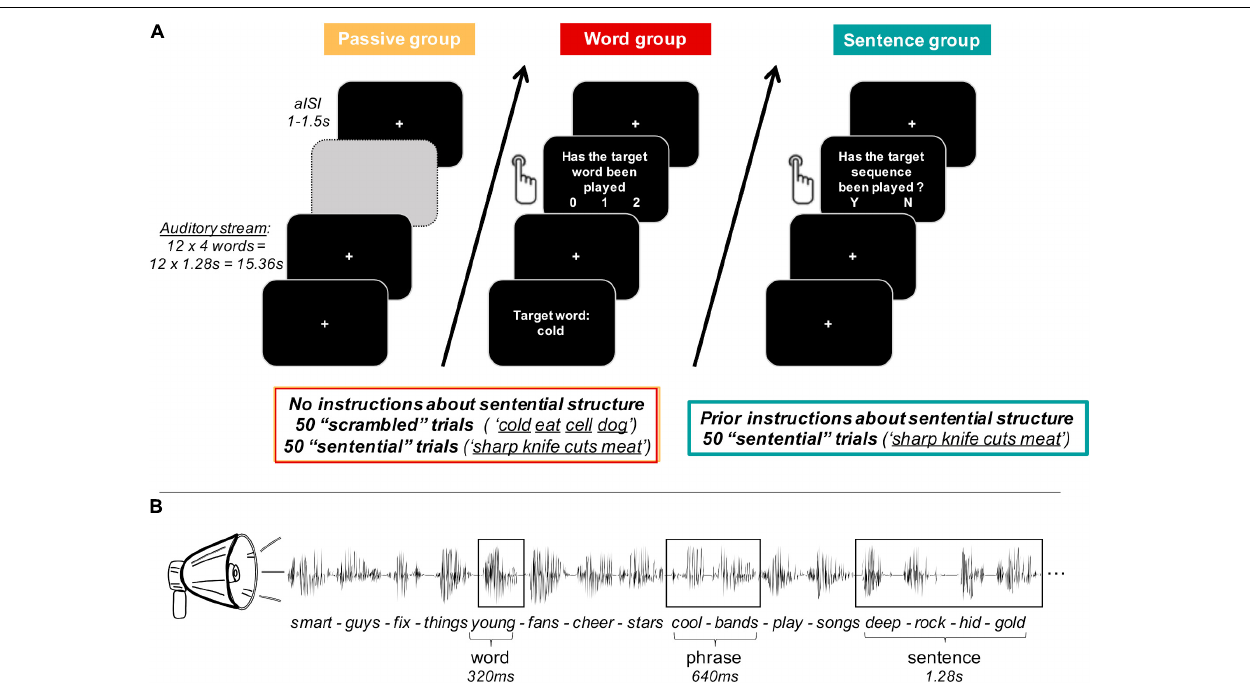
FIGURE 1 | Experimental paradigm. (A) Participants were divided into three groups of 24 participants each. For every group, auditory stimuli of each trial were presented as a continuous stream of 12 four-word-sequences, which were built by concatenating isochronous single words of 320 ms length each. The passive group (orange) was naïve to the sentential structure of the stimulus material and passively listened to the auditory stream. The word group (red) was also naïve to the sentential structure and had an active task based on individual target words. After each trial, participants were asked whether the target word had been presented 0, 1, or 2 times. Both the passive and the word group were exposed to stimuli of the scrambled condition (unrelated words) and the sentential condition (four consecutive words built a meaningful sentence). The sentence group (turquoise) was instructed about the sentential structure in the stimulus material and was only listening to the sentential condition. Participants were asked to report via button press after each trial, whether a grammatically incorrect four-word-sequence had been played in the respective trial. For each participant group, individual trials were separated by an asynchronous inter-stimulus-interval (aISI) of 1–1.5 s. (Greyed out field only serves visualisation purposes of this figure.) (B) Example of four four-word-sentences (sentential condition only) to illustrate temporal properties of individual linguistic